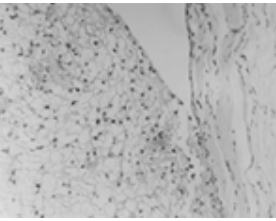
FIGURE 2. Light microscopy showing intraluminal renal cell carcinoma of the spermatic vein. H & E, magnification